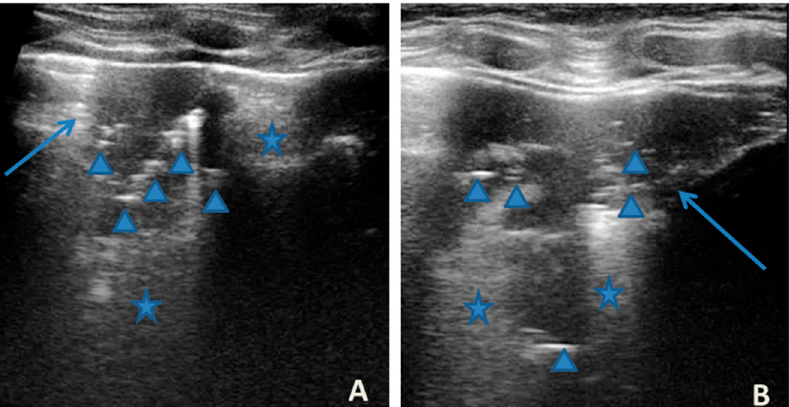
Figure 1. Grayscale lung ultrasound examination shows: ( A ): on the right anterior field, mainly in the mid-apical area, consolidation of atelectasis origin (arrow) with static air bronchograms (punctate), and parallel to each other (arrowheads), associated with sonographic interstitial syndrome (SIS), represented by coalescent vertical artefacts or B-lines (asterisks); ( B ): on the left paracardiac site, consolidation of about 2.5–3 cm of atelectasis nature (arrow) with static air bronchograms (punctate) (arrowheads), associated with sonographic interstitial syndrome (SIS), represented by coalescent vertical artefacts or B-lines (asterisks).